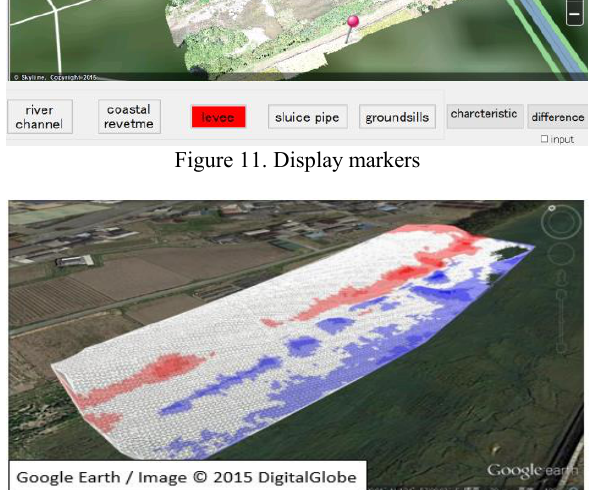
Figure 12. Visualizing differences in three-dimensional